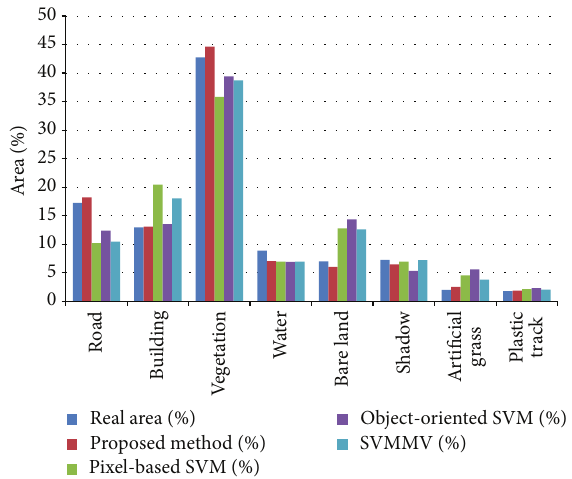
Figure 6: Area statistics of QuickBird data classification